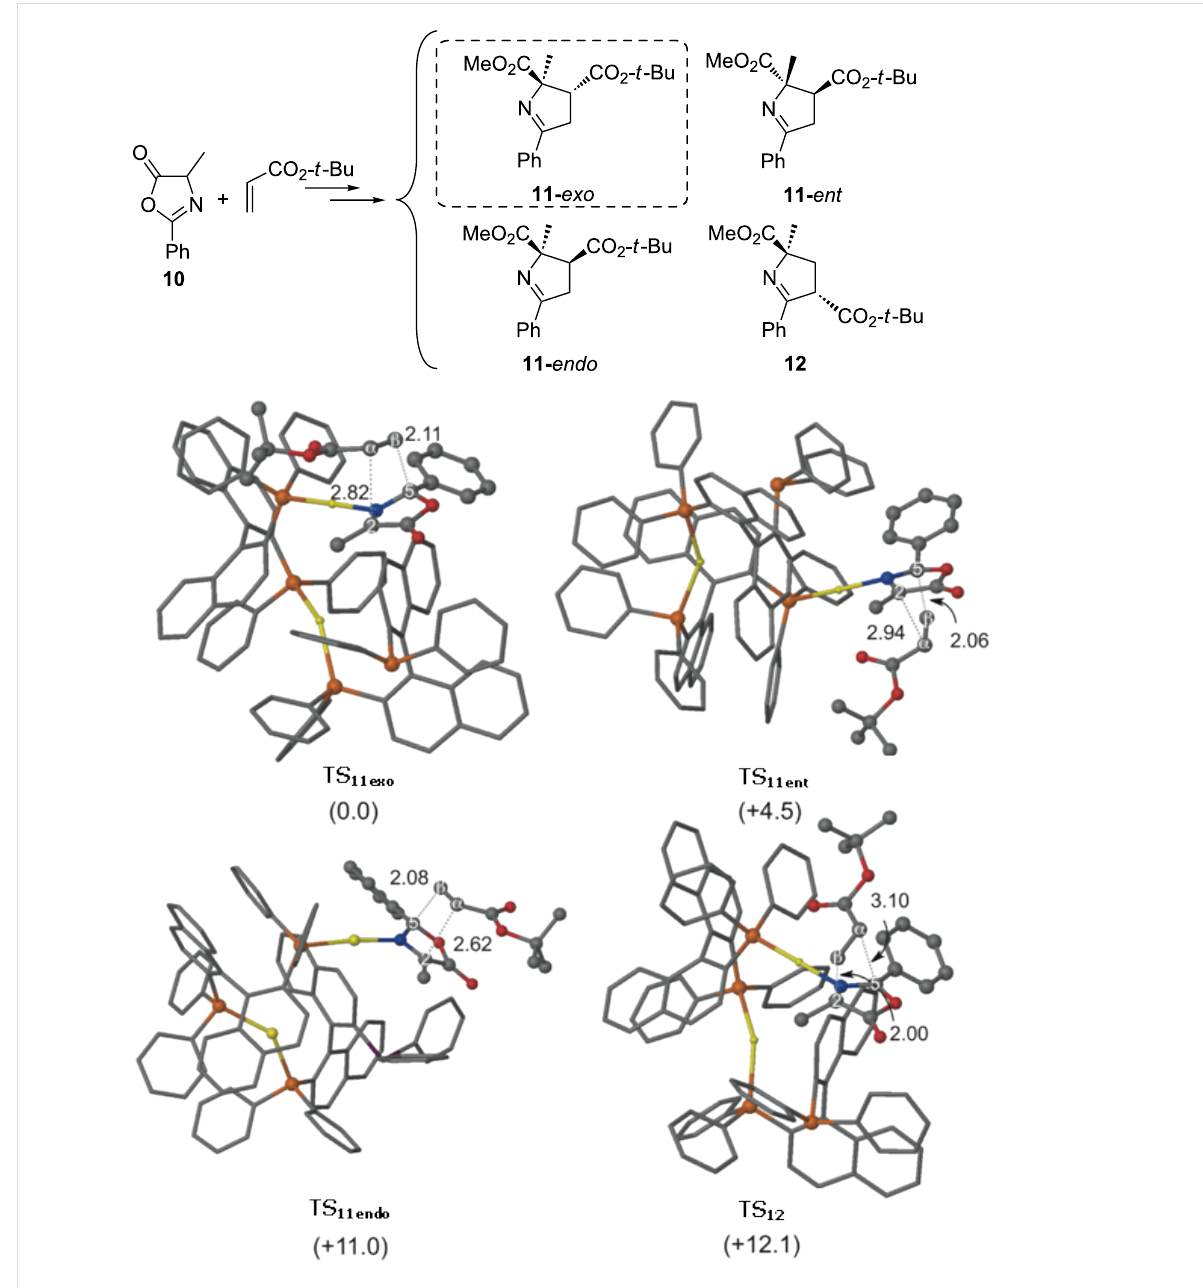
Figure 7: Main geometrical features and relative Gibbs free energies (in kcal mol − 1 ) of the less energetic transition states associated with the 1,3-DC of 10 and tert -butyl acrylate catalyzed by ( S a )-Binap gold dimers computed at M06/Lanl2dz//ONIOM(b3lyp/Lanl2dz:UFF). High-level and low level layers are represented as ball and stick and wireframe models, respectively. Distances are in Å. Hydrogen atoms are omitted for clarity.